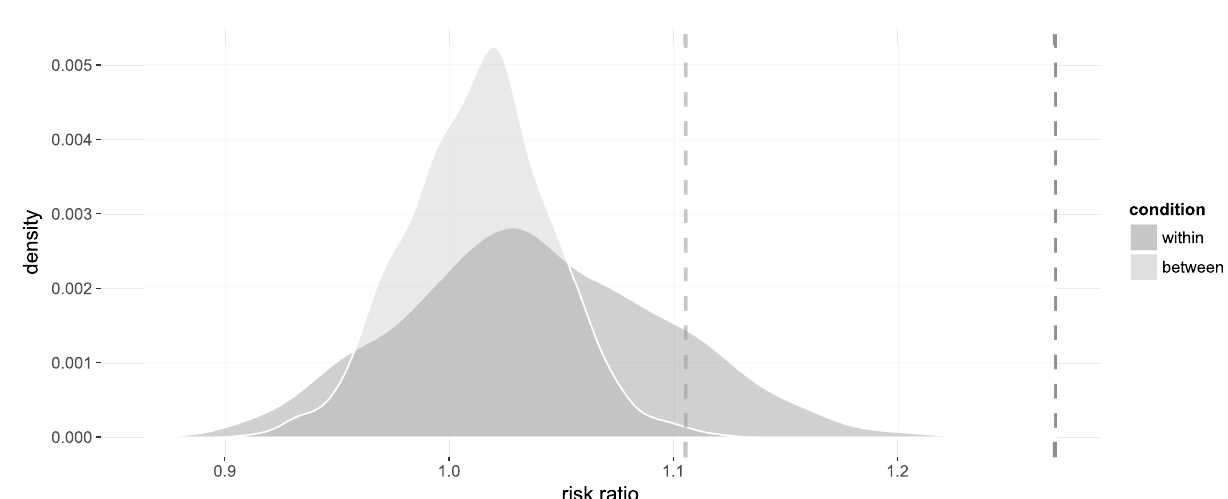
Fig 4. Probability distributions of relative risks in the within- and between-group designs under the null hypothesis that choices are randomly allocated irrespective of country of origin. The dashed lines represent the observed risk